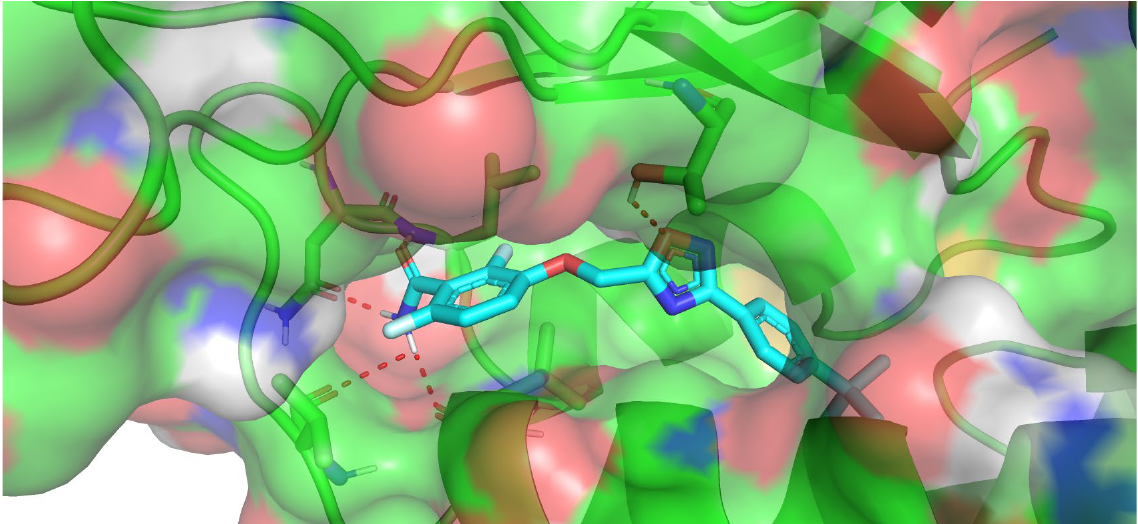
Figure 4. Docking results within the allosteric binding site of FtsZ obtained for compound II.c .